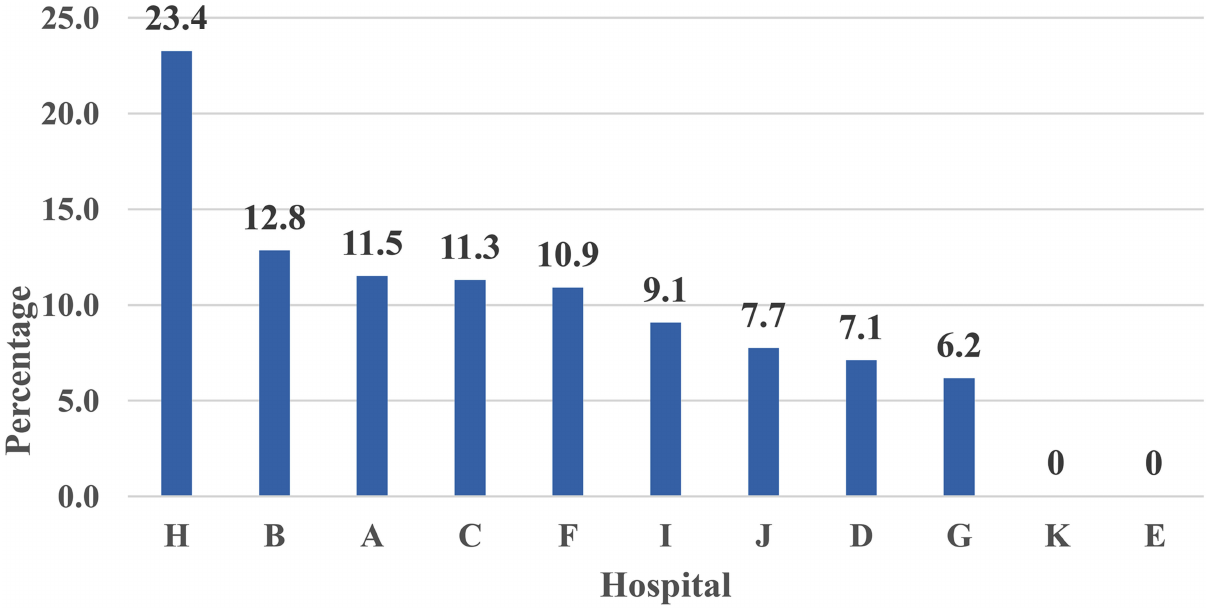
the United States, this percentage was 18%, while in China it was 4% and 9% in Italy (17). The availability of high- quality personal protective equipment (PPE) kits, proper use